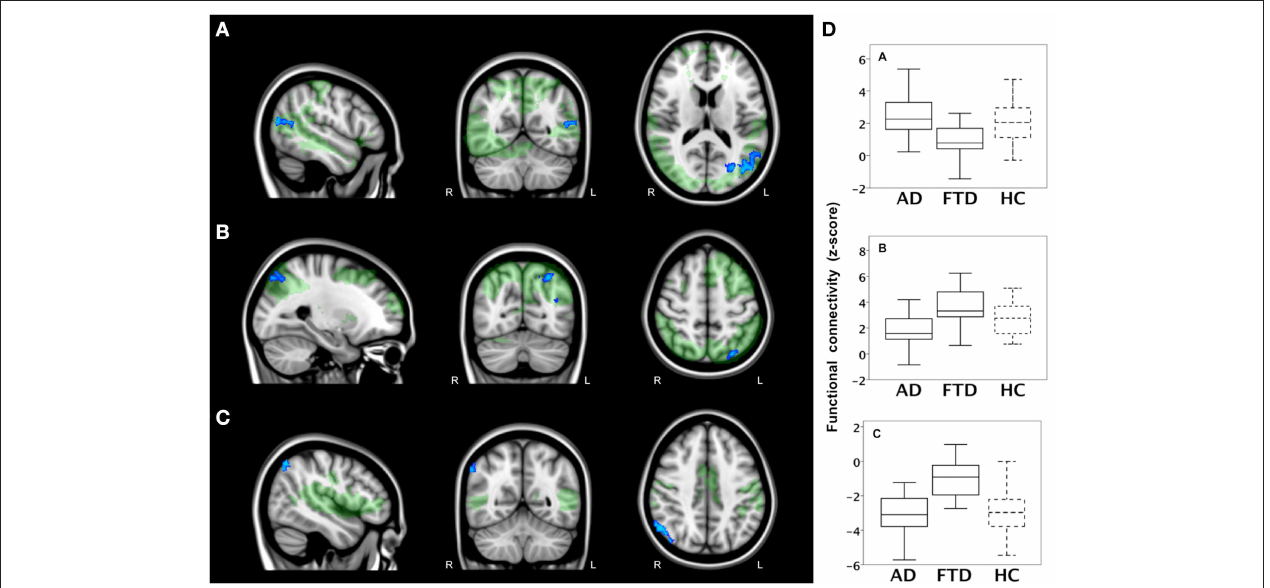
FIGURE 2 | Functional connectivity in bvFTD vs. AD: network-to-region connectivity. Differences in functional connectivity between green networks and blue voxels in behavioral variant frontotemporal dementia (FTD) and Alzheimer’s disease (AD) (TFCE, FWE-corrected). (A) Decreased functional connectivity between lateral visual cortical network (green) and lateral occipital cortex and cuneal cortex (blue) in bvFTD compared with AD. (B) Decreased functional connectivity between dorsal visual stream network (green) and lateral occipital cortex and parietal opercular cortex (blue) in AD compared with bvFTD. (C) Less negative functional connectivity between auditory system network (green) and angular gyrus (blue) in bvFTD compared with AD. Images are overlaid on the MNI-152 standard anatomical image. (D) Subjects’ mean z scores were extracted from brain areas with group differences in functional connectivity (blue areas). Boxplots show median, lower, and upper quartile, and sample minimum and maximum z scores for patients with AD, patients with bvFTD, and healthy controls (HC, dotted